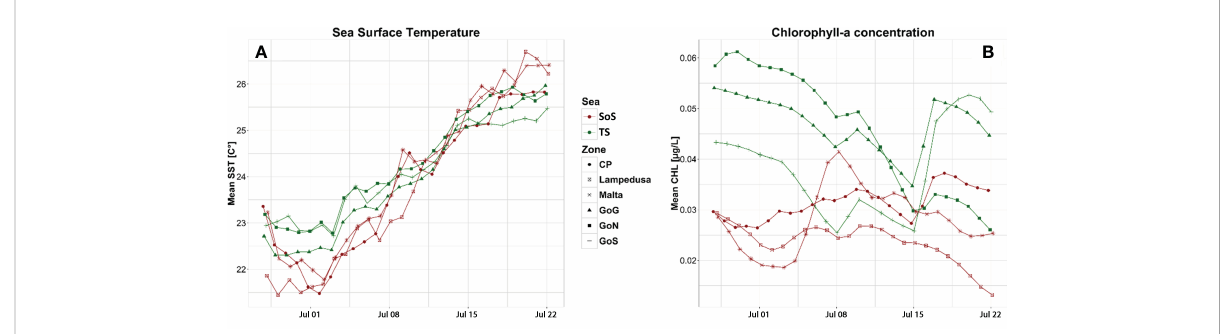
FIGURE 4 Daily average values of the two satellite parameters, SST (A) and CHL (B) , occurring in the identi fi ed spawning grounds for S. aurita based on the egg distribution. Time period from June 29th to July 22th was selected based on the duration of planktonic phase of larvae as derived from otolith analysis. TS, Central-Eastern Tyrrhenian Sea; SoS, Strait of Sicily; CP, Capo Passero; GoG, Gulf on Gaeta; GoN, Gulf of Naples; GoS, Gulf of